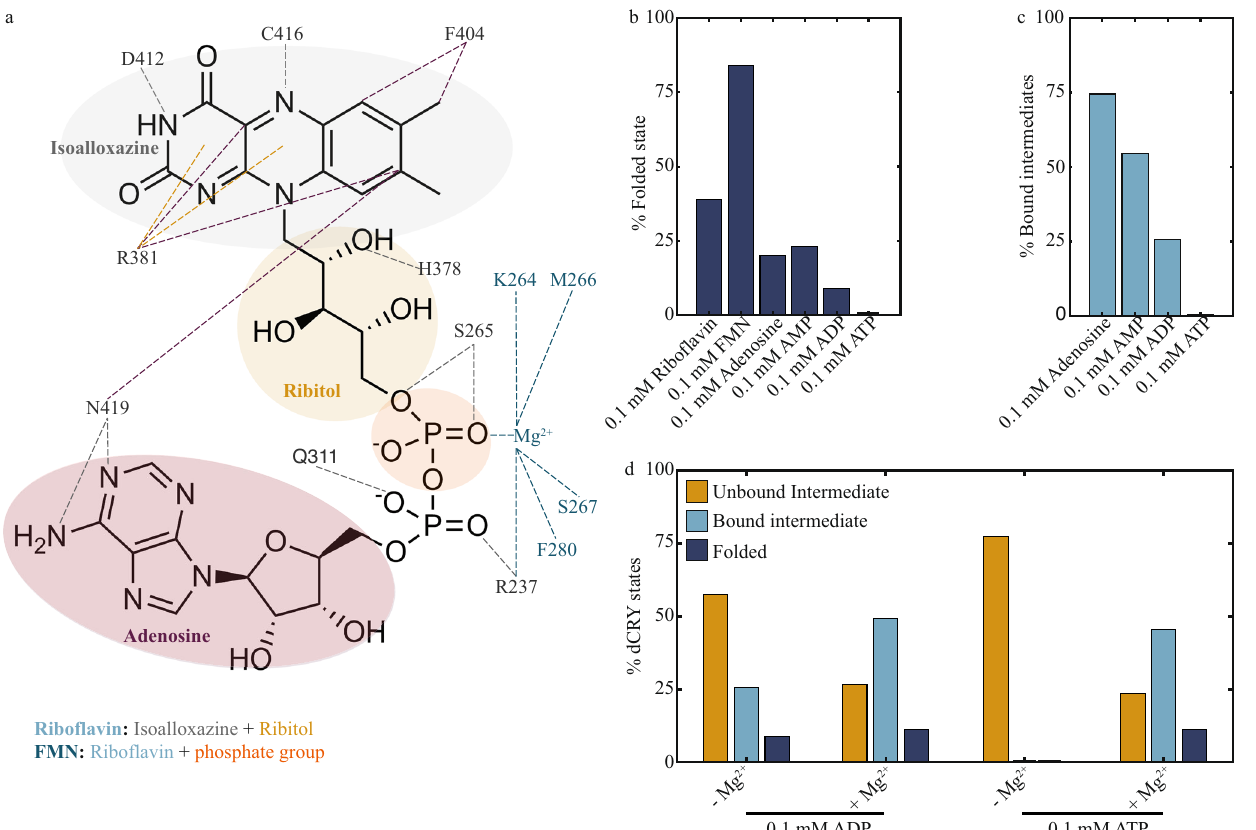
Fig. 4 | Contribution of FAD moieties to dCRY folding. a Contact map between FAD moieties and amino acid residues in dCRY. Interactions include hydrogen bonding (gray), hydrophobic effect (purple), metal coordination (dark teal) and cation-pi interactions (ochre). b Bar plot representing the percentage of dCRY in the folded state in the presence of different cofactors. c Bar plot of percentage of